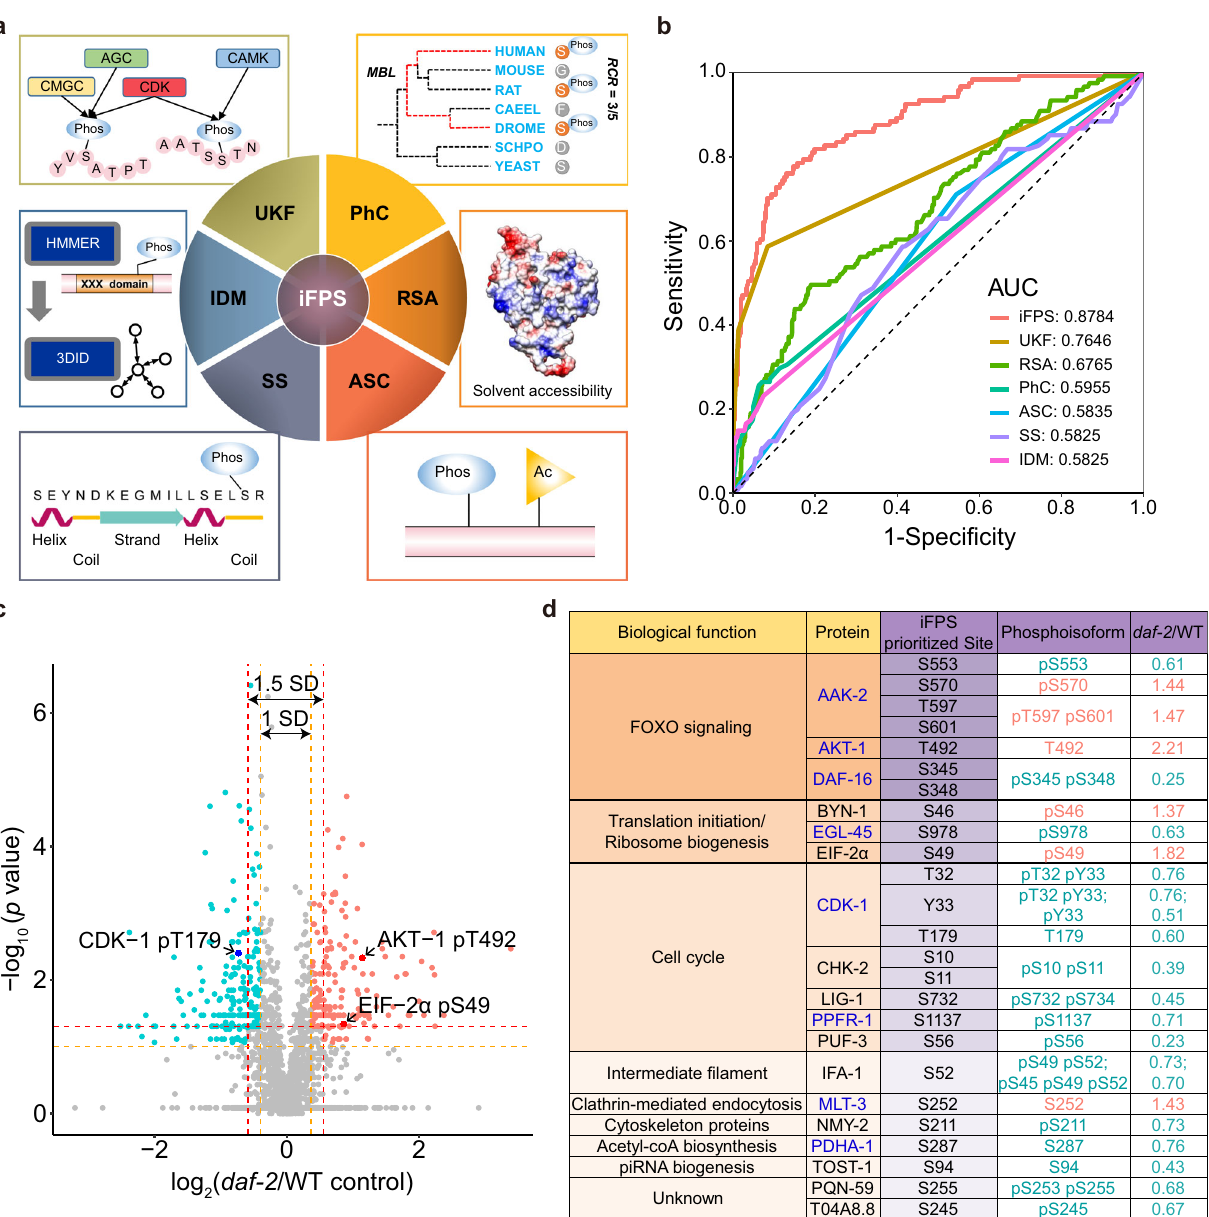
Fig. 2 Discerning functionally relevant clues from the phosphoproteome. a Schematic diagram illustrating the design of iFPS, which employs multinomial logistic regression from machine learning to integrate six features and predict the functionally impactful phosphosites in C. elegans . iFPS inference of functional phosphosites, UKF upstream kinase family, PhC phosphorylation conservation, RSA relative surface accessibility, ASC acetylation site co-occurrence, SS secondary structure, IDM interacting domain and/or motif, RCR residue conservation ratio, CMGC/AGC/CDK/ CAMK kinase groups, HMMER software that predicts functional domain, 3did database of three-dimensional interacting domains, Phos phosphorylation, Ac acetylation. b Prediction power (AUC, area under the curve) of different models. One hundred and one known functional phosphosites and 605 randomly phosphosites from dbPAF served as the training data set. Tenfold cross-validations were performed. The iFPS model, which integrated six features, was superior to models constructed from individual feature. c Phosphorylation changes in the long-lived daf-2 mutant compared to the WT control (see “ Methods ” ). Phosphoisoforms quanti fi ed at least three times in both daf-2 and WT control were subjected to statistical comparison. The log 2 [median of ( 14 N/ 15 N) daf-2 )/median of ( 14 N/ 15 N) control ] values and the log 10 ( p value, Wilcoxon rank-sum test) of phosphoisoforms were plotted on the x axis and y axis, respectively. Dots ( n = 2365 phosphoisoforms) met the criteria of [log2(fold change) beyond 1.5× SD and one-tailed p value < 0.05] or [log2(fold change) beyond 1.0× SD and two-tailed p value < 0.05] are colored in red (hyper-phosphorylated) or green (hypo-phosphorylated). AKT-1 pT492, EIF-2 α pS49, and CDK-1 pT179 are functionally validated in this study. See statistics in Source data. d Prioritizing the daf-2 -regulated phosphosites by iFPS ranking. The daf-2 -regulated phosphosites that ranked among the top 5% highest scoring iFPS phosphosites are shown. Proteins were grouped by KEGG ontology or function annotations recorded in WormBase release WS275. Royal blue marks the lifespan-regulating proteins. Red colors the upregulated phosphoisoforms. Green colors the downregulated phosphoisoforms. The daf-2 /WT values are the relative phosphorylation levels of phosphoisoforms in daf-2 compared to